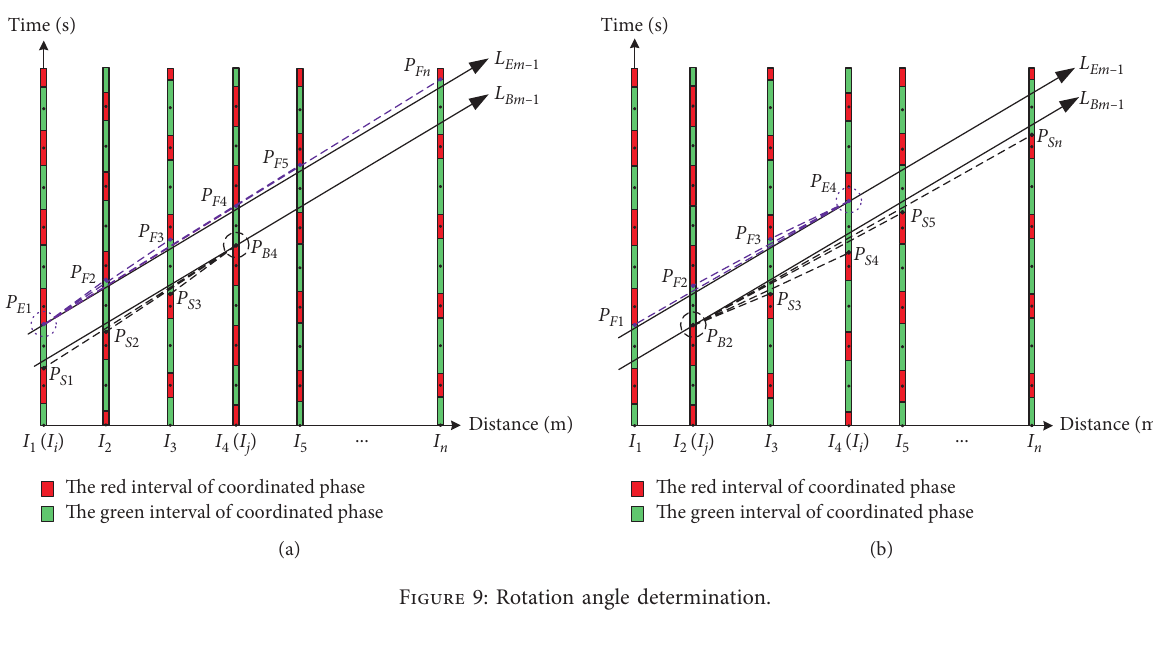
Figure 9: Rotation angle